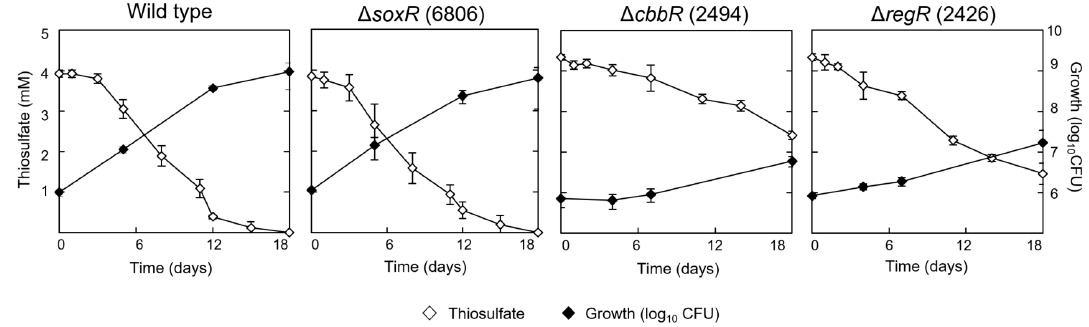
Figure 4. Contribution of transcription regulators to chemolithoautotrophic growth of B. diazoefficiens with thiosulfate and CO 2 . The analyzed strains were the wild type and the regulatory mutants 6806 (lacking the SoxR repressor), 2494 (lacking the CbbR activator), and 2426 (lacking the RegR response regulator of the two-component RegSR system). The starting media contained 4 mM thiosulfate. The panels show thiosulfate consumption and growth measured as colony-forming units (CFU). Shown are the mean values and standard deviation derived from three independent cultures.